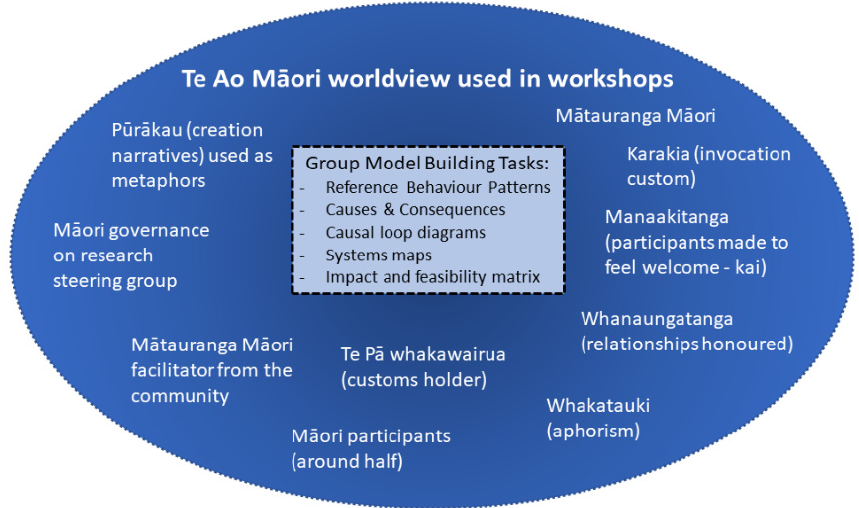
Figure 1. Group Model Building workshop tools and tasks embedded in a Te Ao M ā ori worldview (M ā tauranga M ā ori–Indigenous Knowledge;